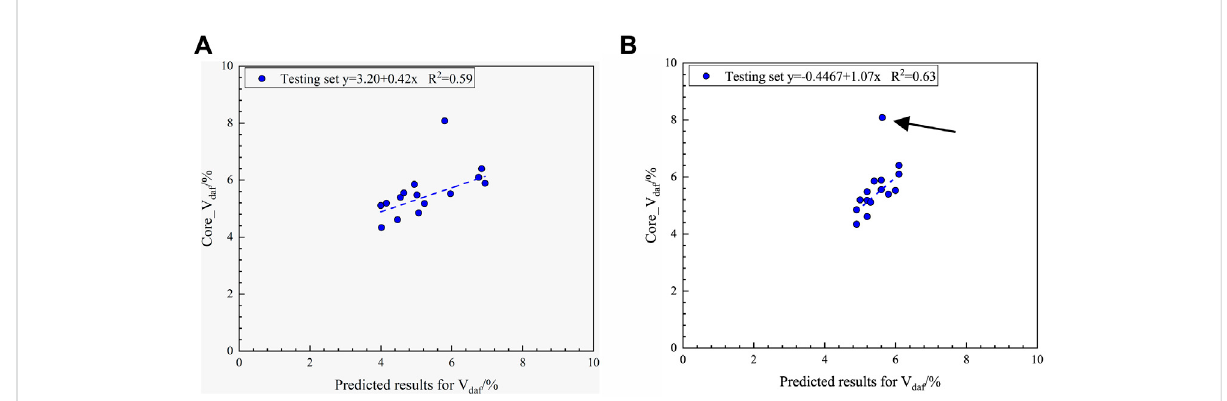
FIGURE 7 (A) Application effect of the Vd af content prediction model constructed using industrial component content autocorrelation. (B) Application effectoftheVd af contentpredictionmodelconstructedusingthegeophysicalloggingcurvesandtheindustrialcomponentcontentscombinedwith OBGM (1, 5)